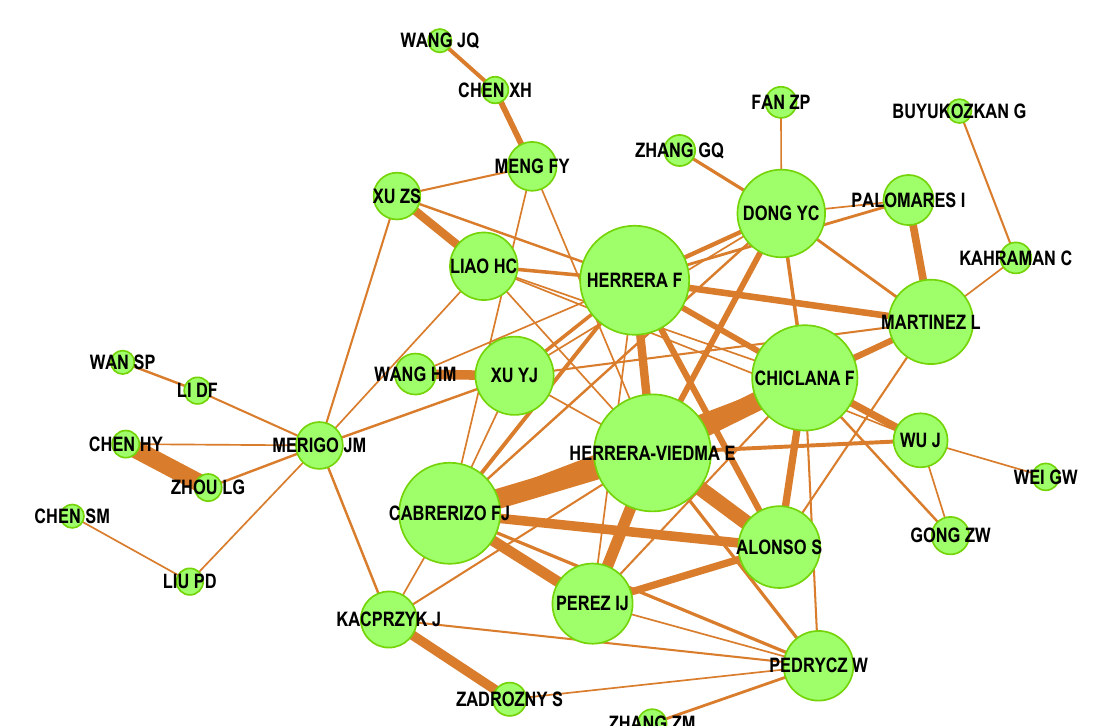
Figure 9. Collaboration network of the 1% most prolific authors.